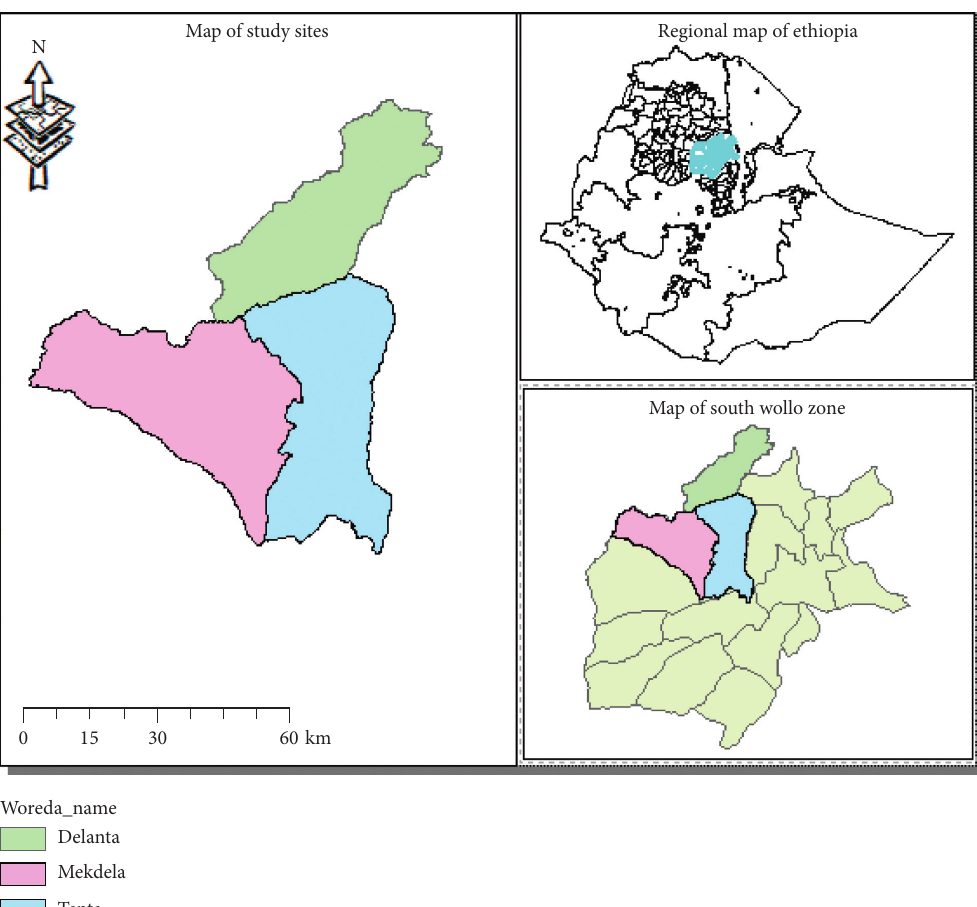
Figure 1: Map of Ethiopia (above right), South Wollo Zone (below right), and study sites (left